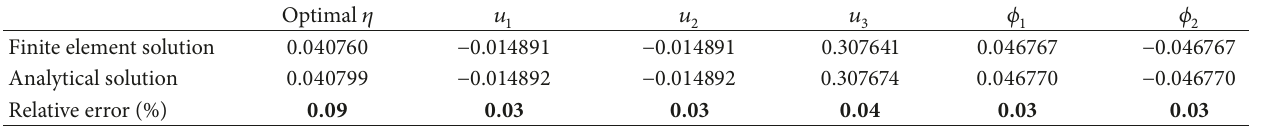
Table 7: Relative error of the maximum values of the displacement and